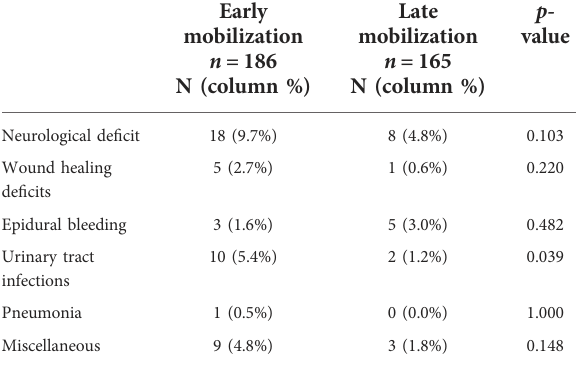
TABLE 5 Complications following early and late